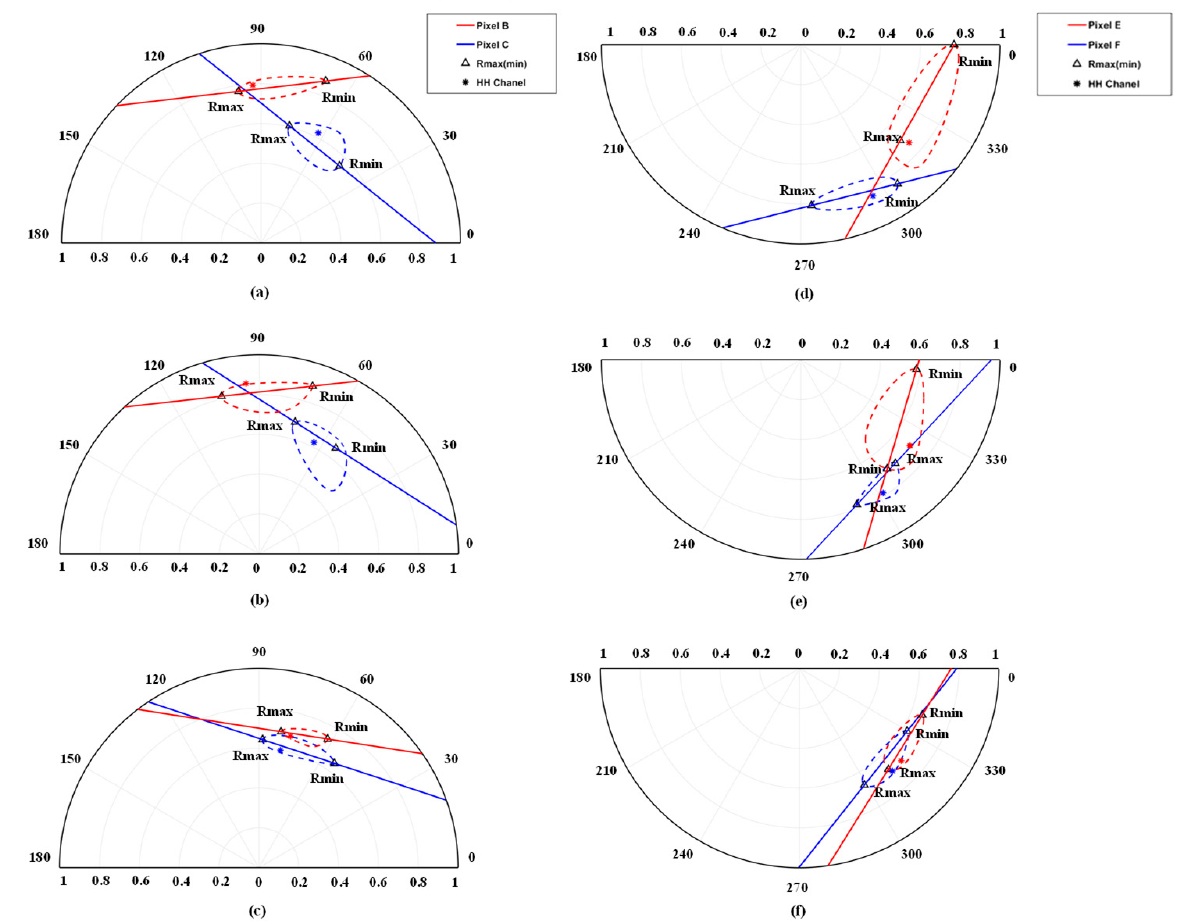
Figure 9. Geometrical interpretation of pixels B and C for the three sizes from the Mabounie and Mondah areas: ( a ) 5 × 5 size from the Mabounie area; ( b ) 9 × 9 size from the Mabounie area; ( c ) 25 × 25 size from the Mabounie area; ( d ) 5 × 5 size from the Mondah area; ( e ) 11 × 11 size from the Mondah area; ( f ) 25 × 25 size from the Mondah area. Note that Rmax is the endpoint near the ground phase, Rmin is the endpoint away from the ground phase, and markers of different colors indicate the coherence amplitude at the HH channel under different sizes.